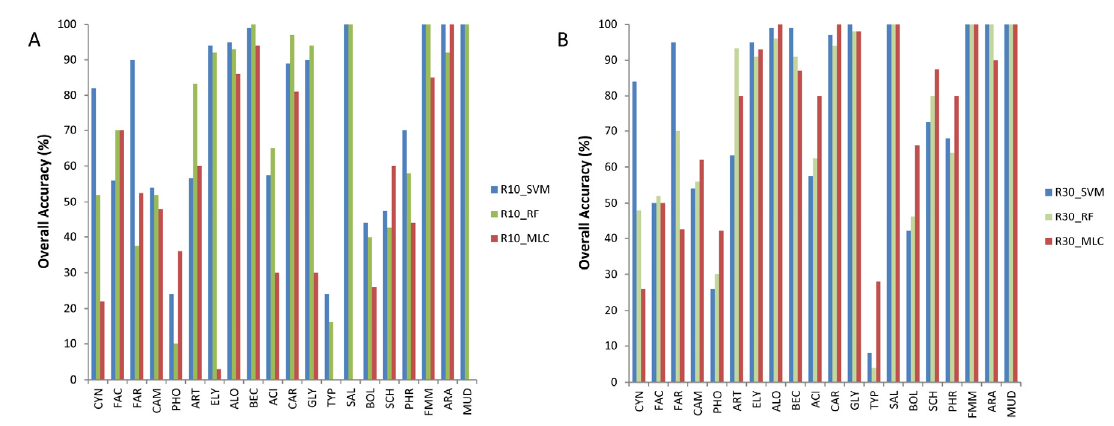
Figure 9. Producer’s accuracy (%) of the classes using SVM, MLC and RF classifiers using 9 MNF-transformed bands and 10 ( A ) and 30 ( B ) random training pixels.